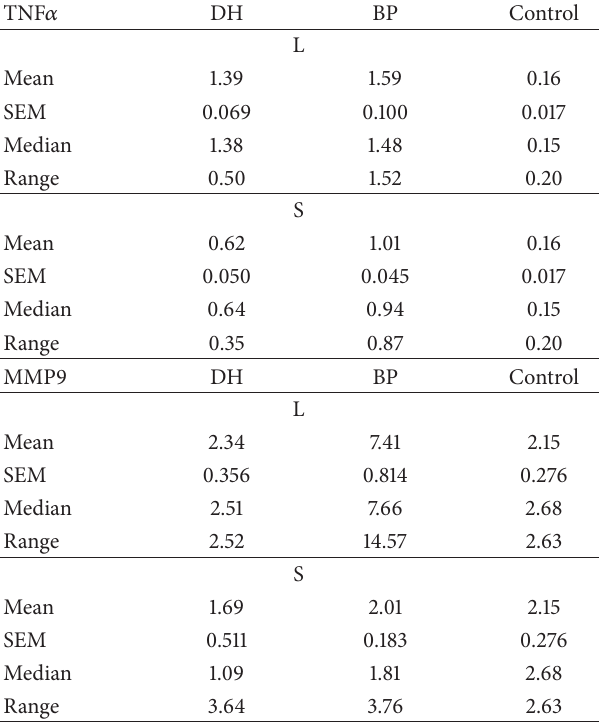
Table 1: The quantitative data of TNF 𝛼 and MMP9 positive cells expressed in BP, DH, and control group (L), in lesion (S) and in the surrounding